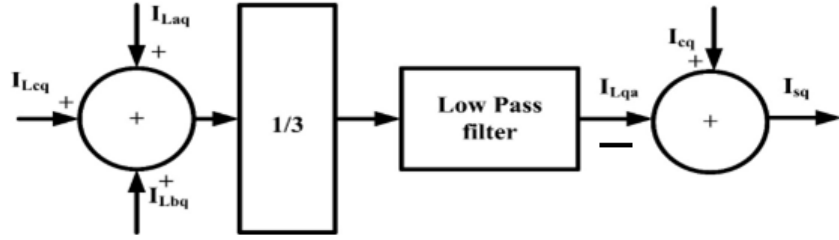
Figure 7. Design of amplitude of q-axis load current .